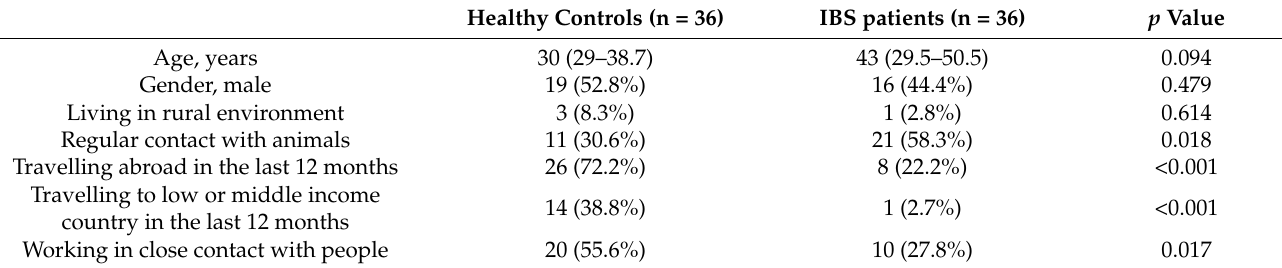
Figure 1. Flow diagram of patients. Table 1. Comparison of epidemiological characteristics between healthy controls and patients with